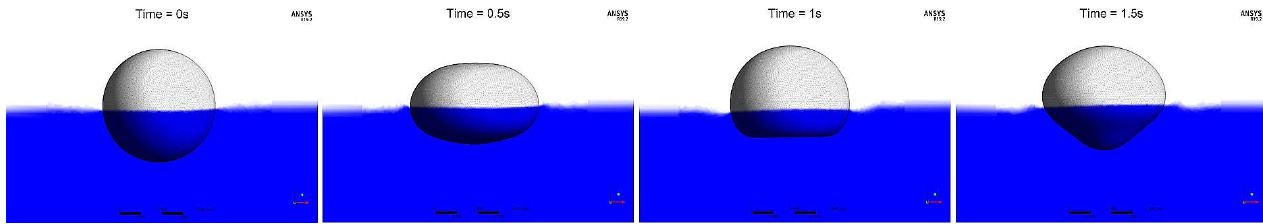
Figure 17. Snapshots of the deformation of VSB WEC at different time